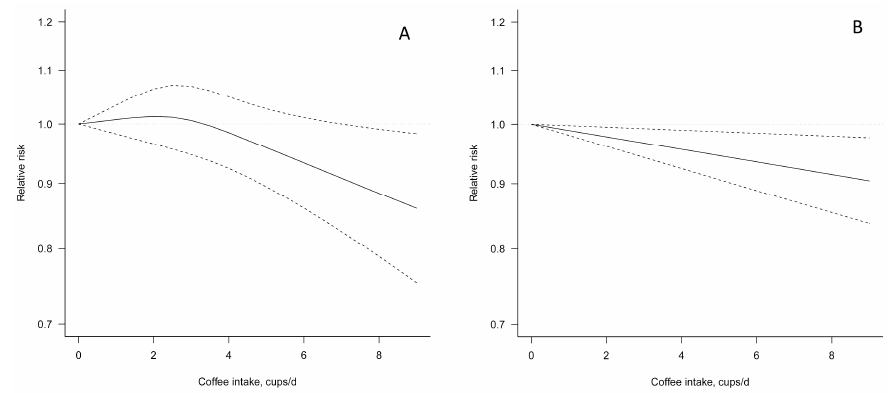
Figure 2. Dose–response association between coffee consumption and risk of hypertension: ( A ) non-linear association; and ( B ) linear association. Solid lines represent risk ratio, dashed lines represent 95% confidence intervals.